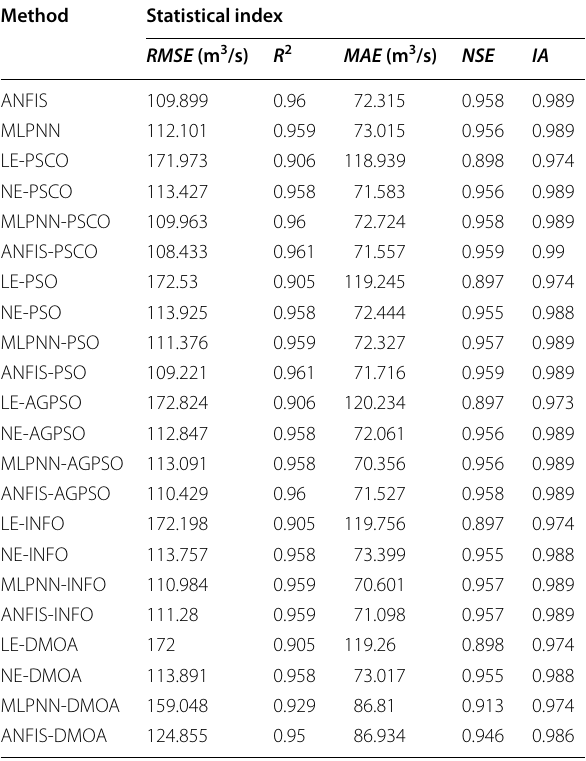
Table 7 Results obtained in testing